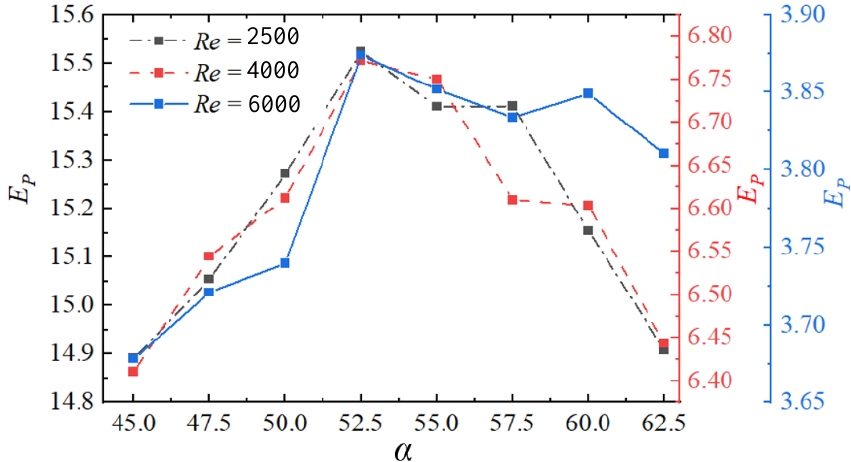
◦ , q = 1 kW/m 2 , and 29%